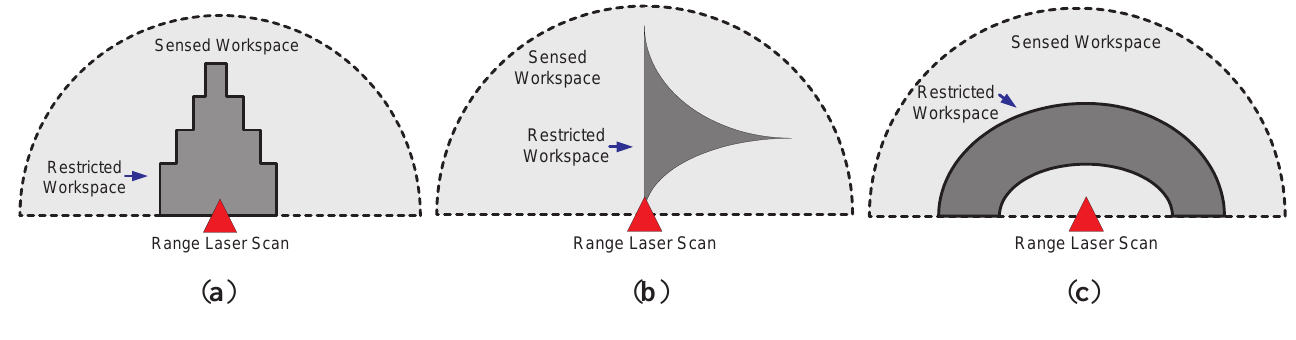
Figure 4. Three examples of restricted workspace